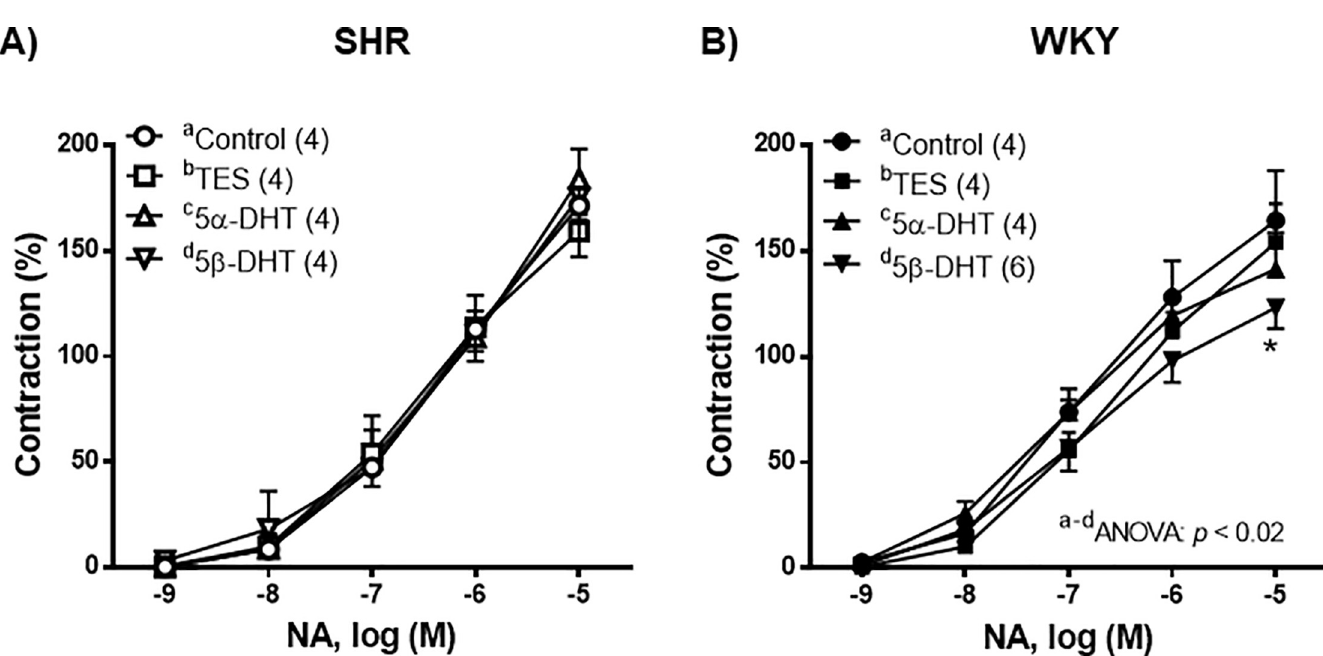
Fig 4. Effect of androgens on the contractile response to noradrenaline (NA). Effect of 10 nM testosterone (TES), 5 α -dihydrotestosterone (5 α -DHT) and 5 β - dihydrotestosterone (DHT) on the concentration-response curves to noradrenaline (NA) in mesenteric arteries of hypertensive (SHR) and normotensive (WKY) rats. Results (mean ± SEM) are expressed as a percentage of the contraction induced by 60 mM KCl. � p < 0.05 compare to control condition (vehicle group). Number of animals used, n = 4–6.